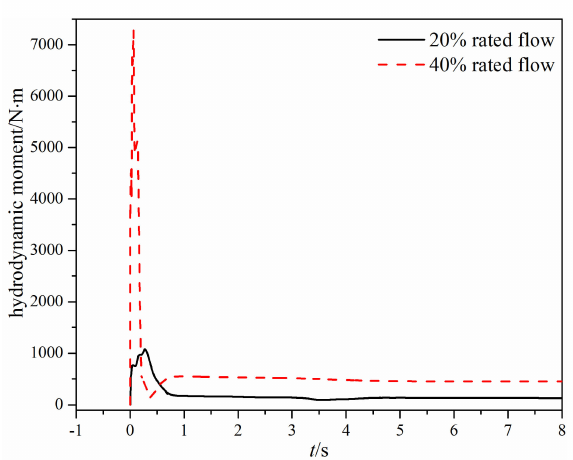
Figure 8. The time-varying hydrodynamic moment under di ff erent mass flow